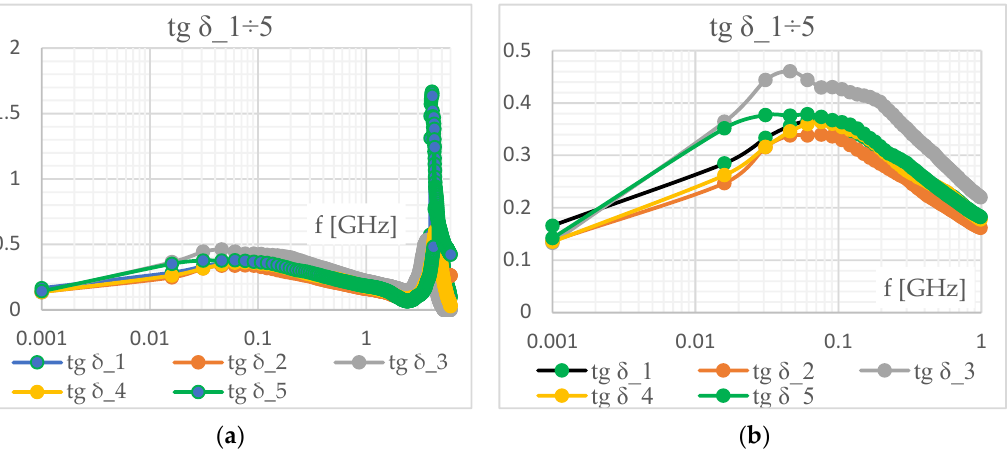
Figure 5. The imaginary part ε (cid:48)(cid:48) r of permittivity for samples #1 ÷ #5 and the following ranges of f: ( a ) 1 MHz ÷ 6 GHz, ( b ) 1 MHz ÷ 1 GHz.